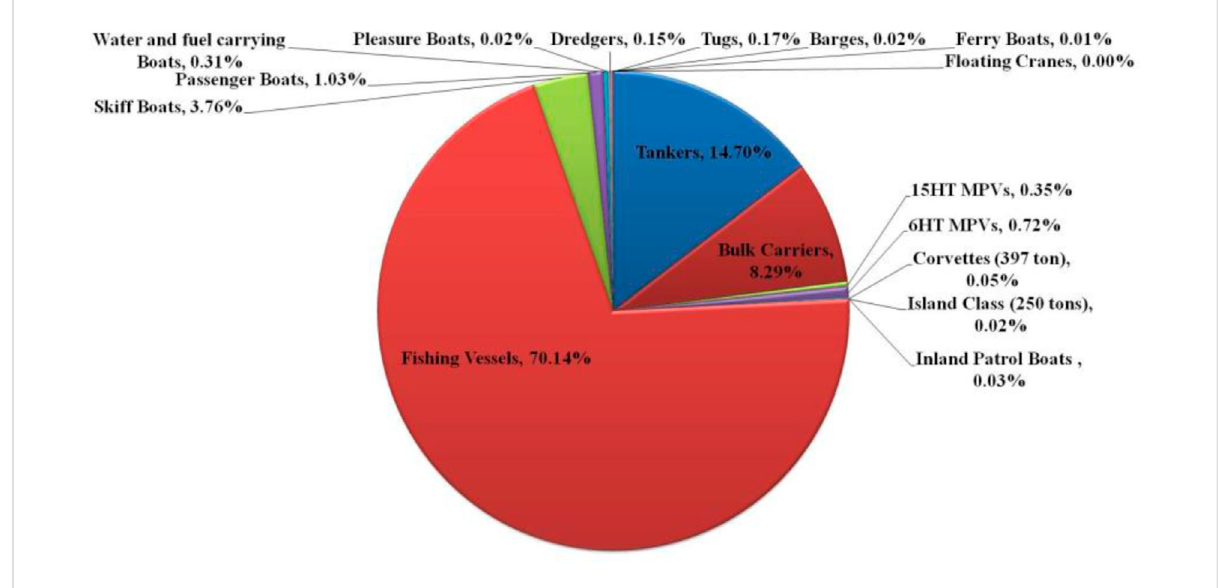
FIGURE 16 Share of GHG emissions (CO 2 e) from all types/sizes of maritime vessels.